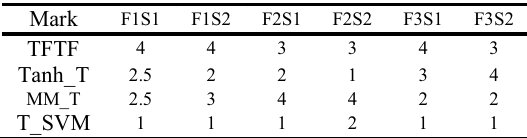
Tab. 6. Performance mark comparison between different